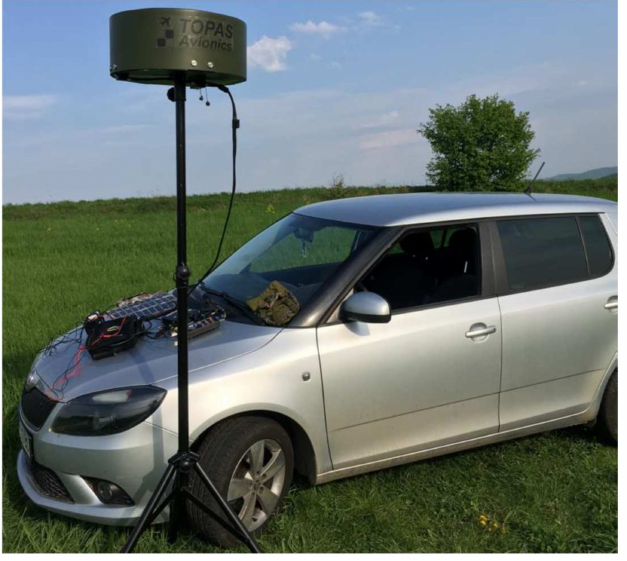
Figure 11. Exterior targeting station of the IDVOR system in the Šandal